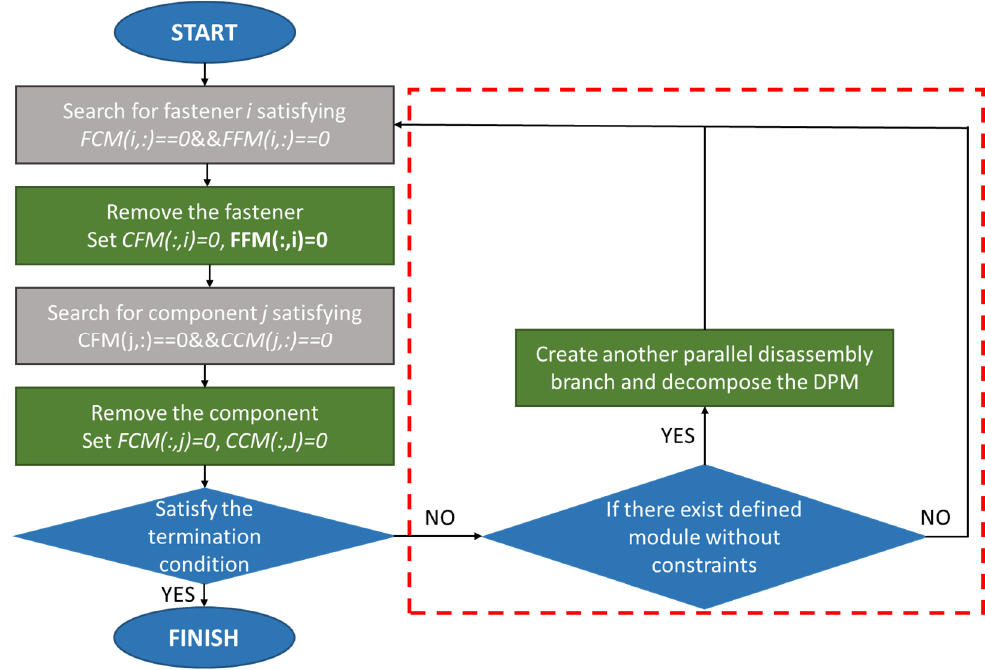
Figure 5. Flow chart for the generation of a partial/parallel disassembly sequence.